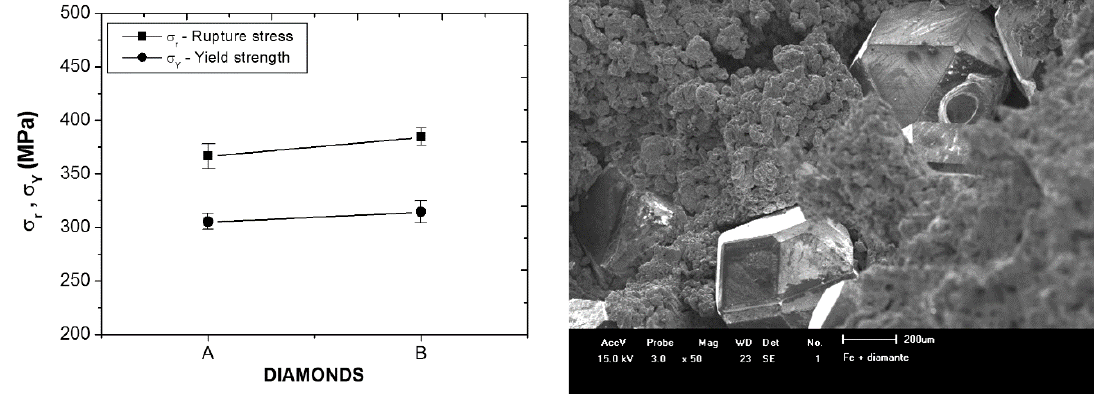
Figure 7. Rupture stress (σ composites. A: uncoated diamonds composites and B: TiC coated diamonds composites.